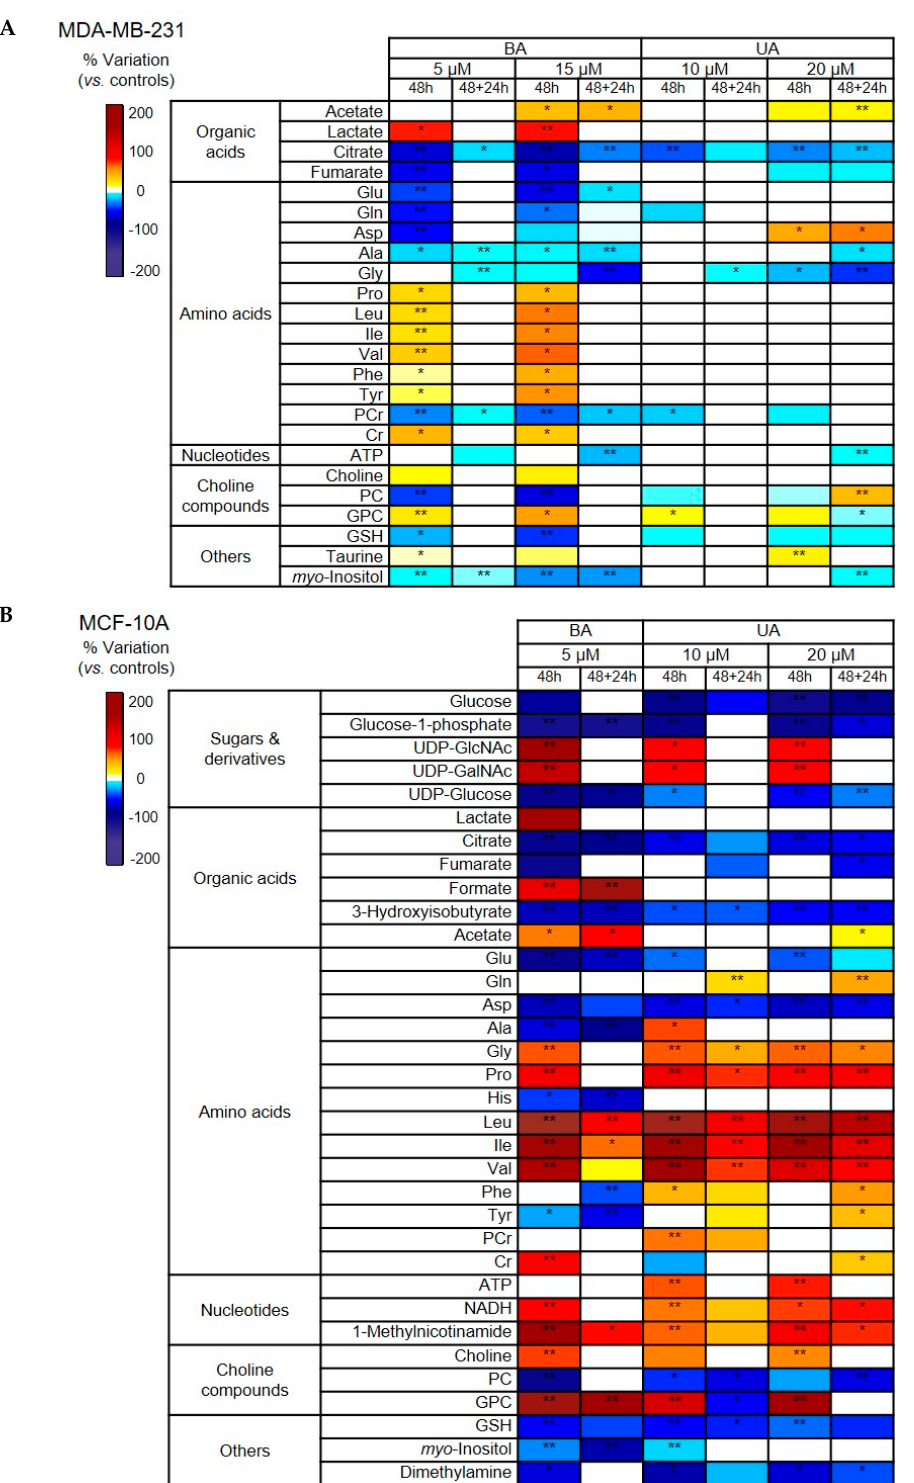
Figure 4. Heatmap of the main metabolite variations in polar extracts of ( A ) MDA-MB-231 cells and ( B ) MCF-10A cells, exposed to betulinic acid (BA) or ursolic acid (UA), colored according to % variation in relation to controls. Four independent replicates considered. * p-value < 0.05, ** p-value < 0.01. Three letter code used for amino acids; Cr, creatine; PCr, phosphocreatine; ATP, adenosine triphosphate; NADH, nicotinamide adenine dinucleotide (reduced); GSH, reduced glutathione; PC, phosphocholine; GPC, glycerophosphocholine; UDP, uridine diphosphate; UDP-GalNAc, UDP-N-acetyl-galactosamine; UDP-GlcNAc, UDP-N-acetyl-glucosamine.